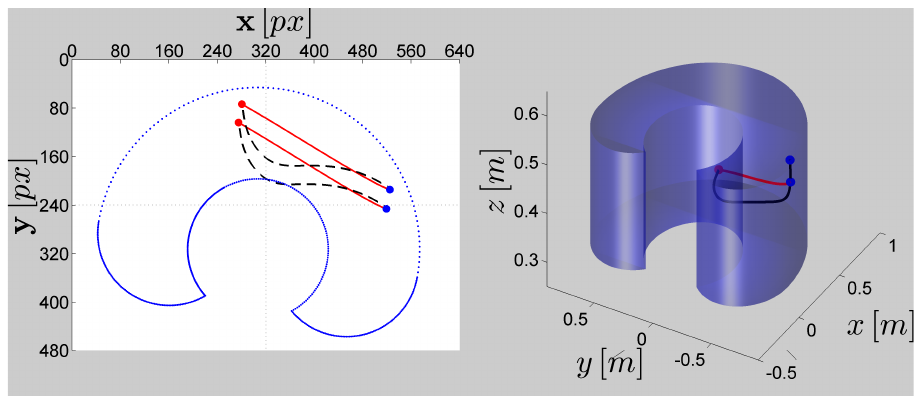
Figure 3. The image features for positioning.